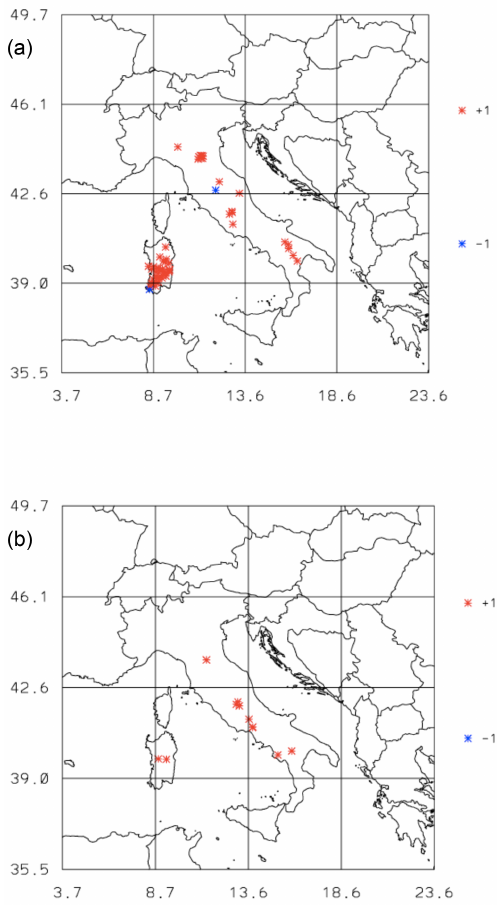
Figure 7. (a) Difference between the hits of the contingency tables of F3HA6 and CNTRL for the 1mm/3h (8mmday − 1 ) forecast; (b) as in (a) for the 10mm/3h (80mmday − 1 )